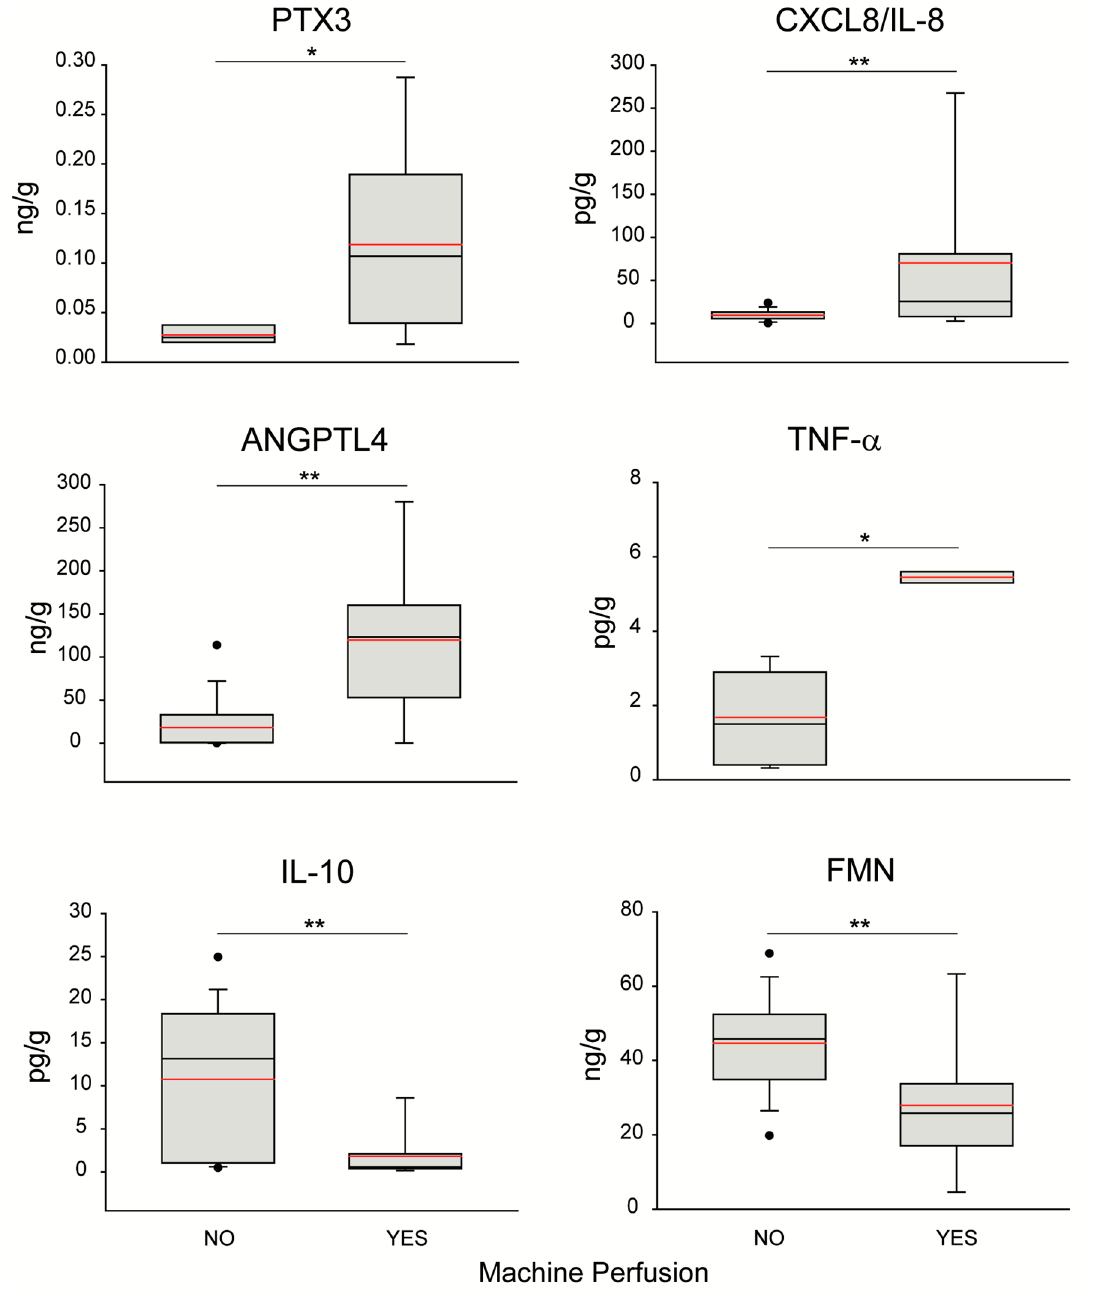
Figure 2. Differences in relevant variable concentration measured in effluent fluids collected from livers referred to the MP procedure compared to those retrieved from grafts transplanted without MP. Boxes denote median 5th–95th percentiles; red lines highlight the mean of each study group, while black points denote outliers. Statistical significance was investigated using Wilcoxon non-parametric test. p value: * <0.05; ** <0.01. PTX3, pentraxin-related protein 3; CXCL8/IL8, chemokine (C-X-C motif) ligand 8 or interleukin 8; BUN, blood urea nitrogen; FMN, flavin mononucleotide.